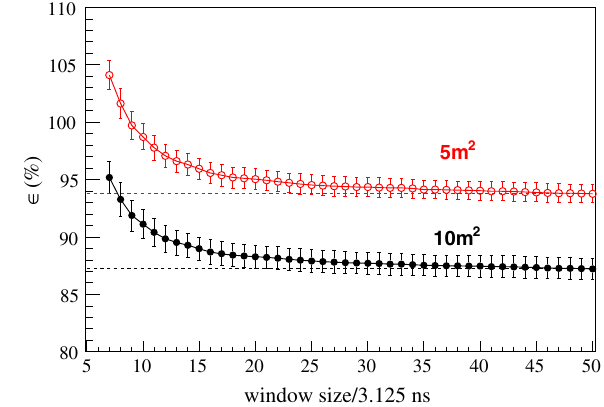
Fig. 5 Efficiency to count individual muons as a function of the time window, for scintillation modules of 10 m 2 (black points and line) and 5 m 2 (red points and